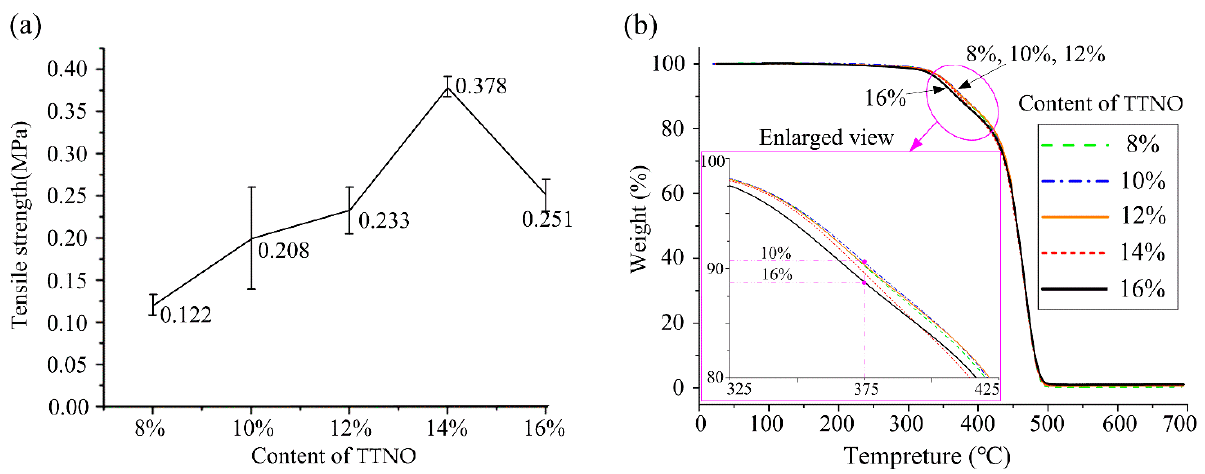
Figure 5. Properties of the rubber material of various TTNO content: ( a ) tensile strength and ( b ) TG curves. ( b ) TG